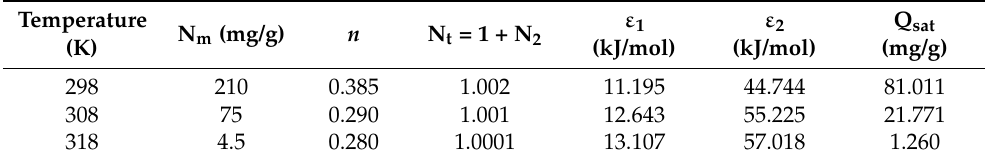
Figure 5. Fitting of mathematical model for the system MD-PbO@MgZnO @ three different temperatures. Table 3. Summary of parameters of the statistical model obtained from MD adsorption onto PbO@MgZnO.